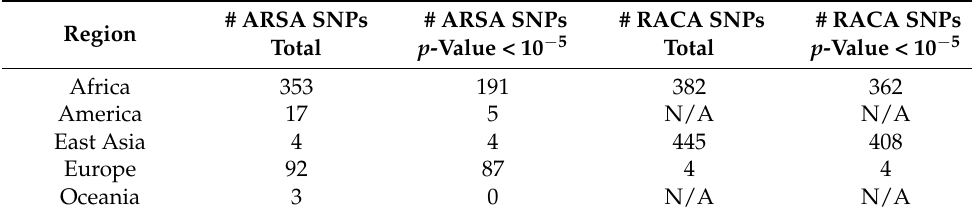
Table 3. Number of SNPs from Tables 1 and 2, with biological effects accessed with BioMart. # ARSA SNPs # ARSA Region Total